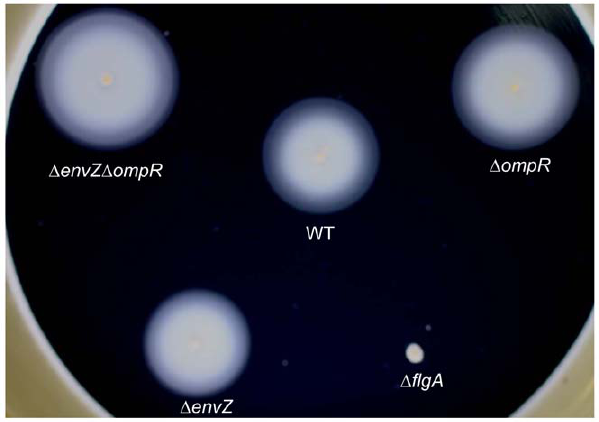
Figure 4. Transcription of envZ and ompR in S.oneidensis under normal and stressed conditions. The relative transcription levels of envZ and ompR were presented as fold increases with respect to expression of 16S rRNA gene. The results were means plus SEM from three independent experiments.